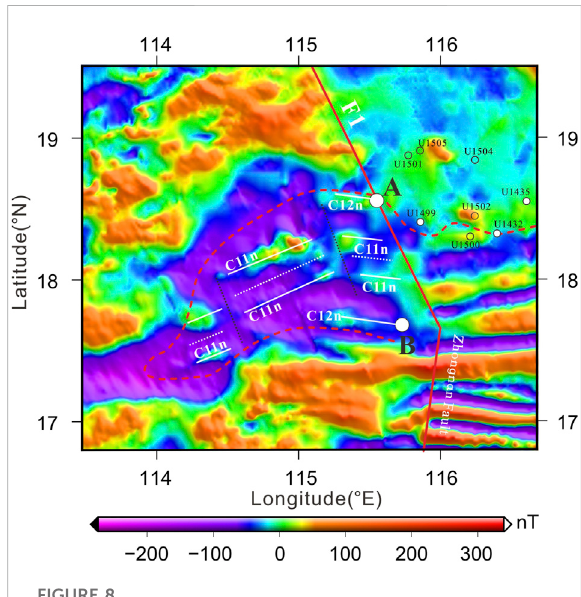
FIGURE 8 Magnetic lineation analysis of the Northwestern